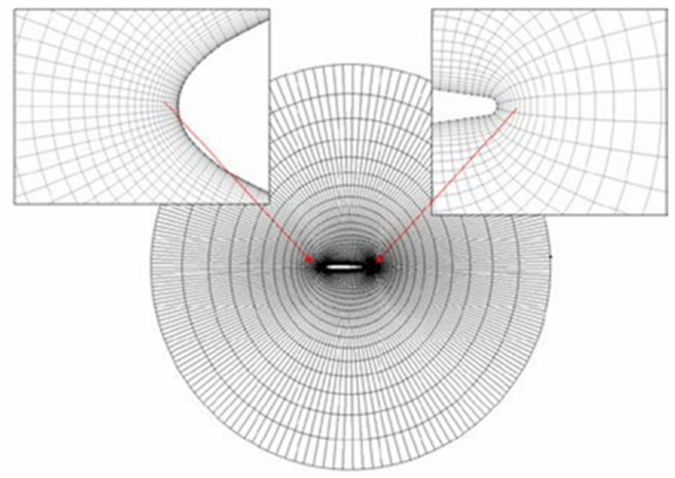
Figure 2. The O type mesh.